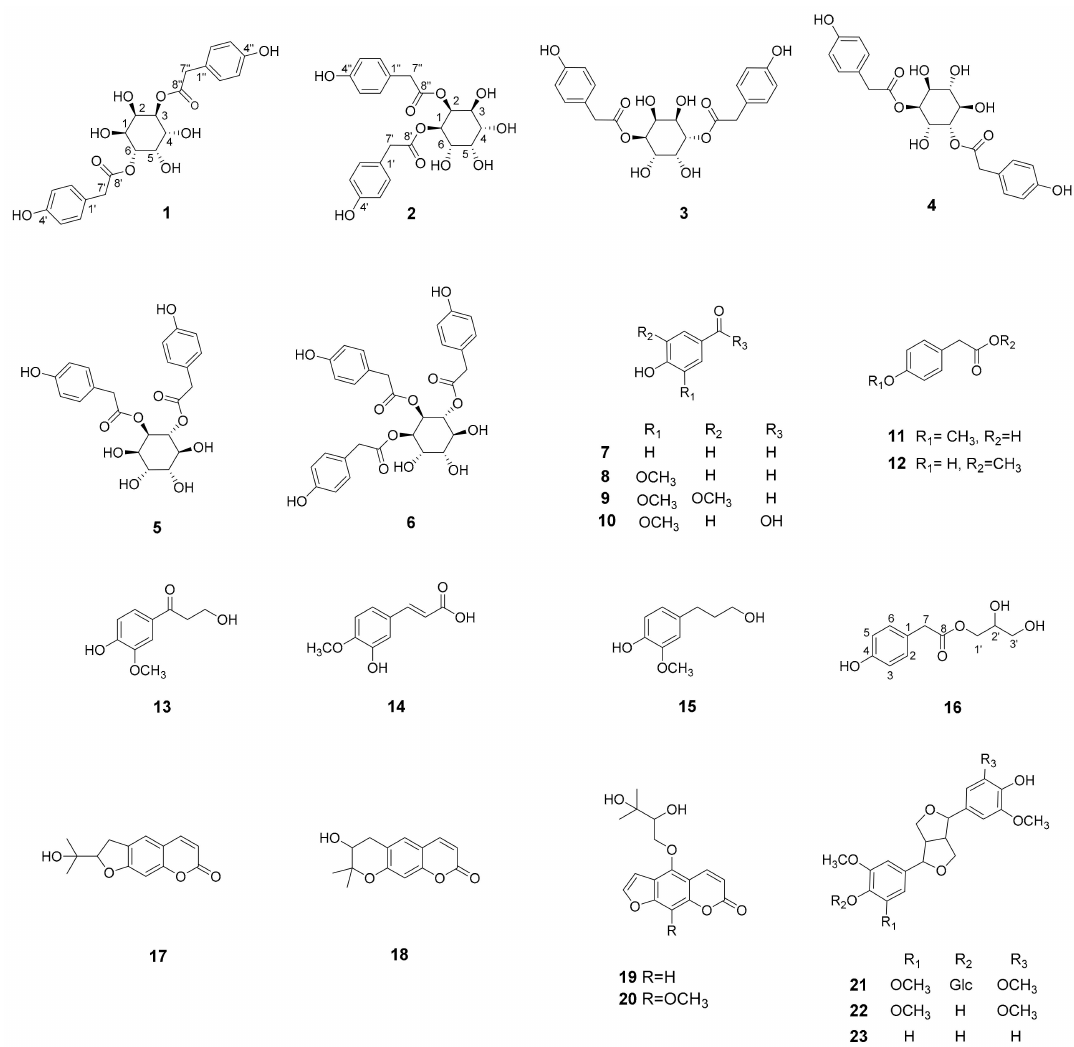
Figure 1. Chemical structures of compounds 1 – 23 from T. coreanum